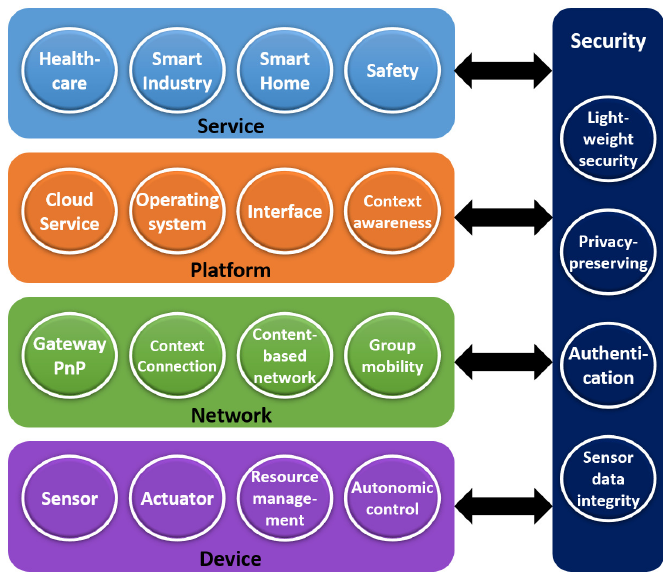
Figure 1. The overview of IoT